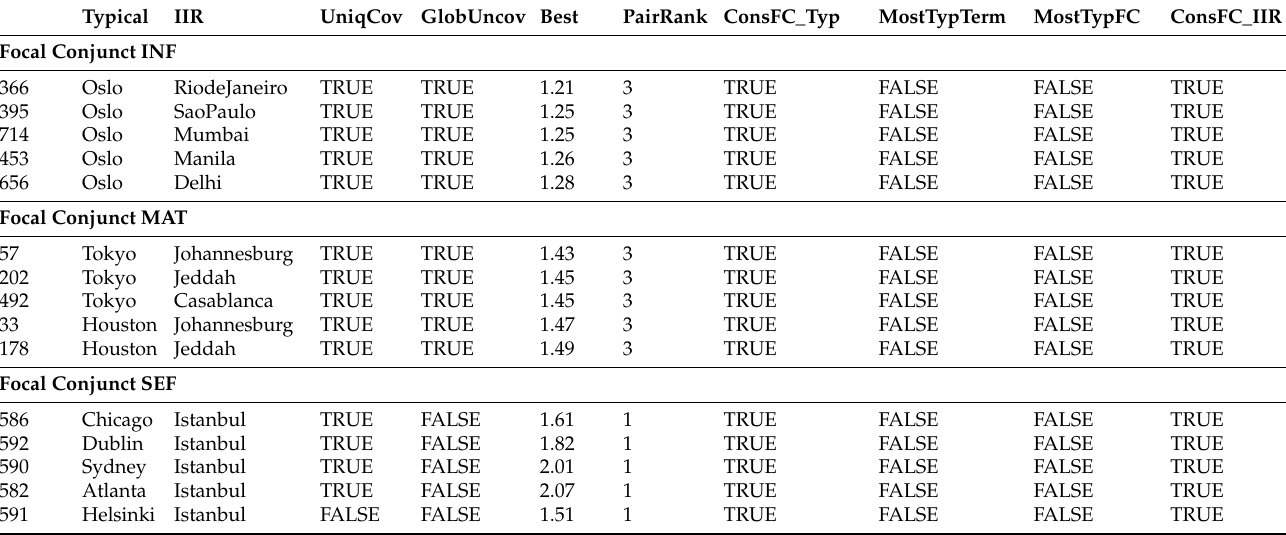
Table 8. IIR typical case Analysis for